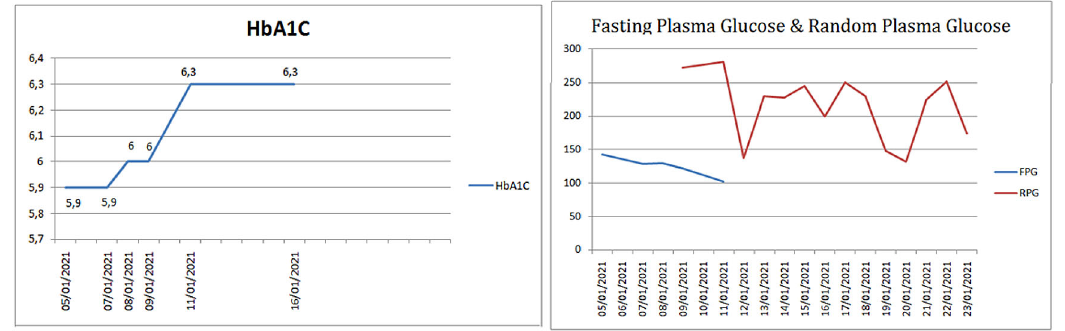
Figure 5. HbA1C, fasting plasma glucose, and random plasma glucose of the